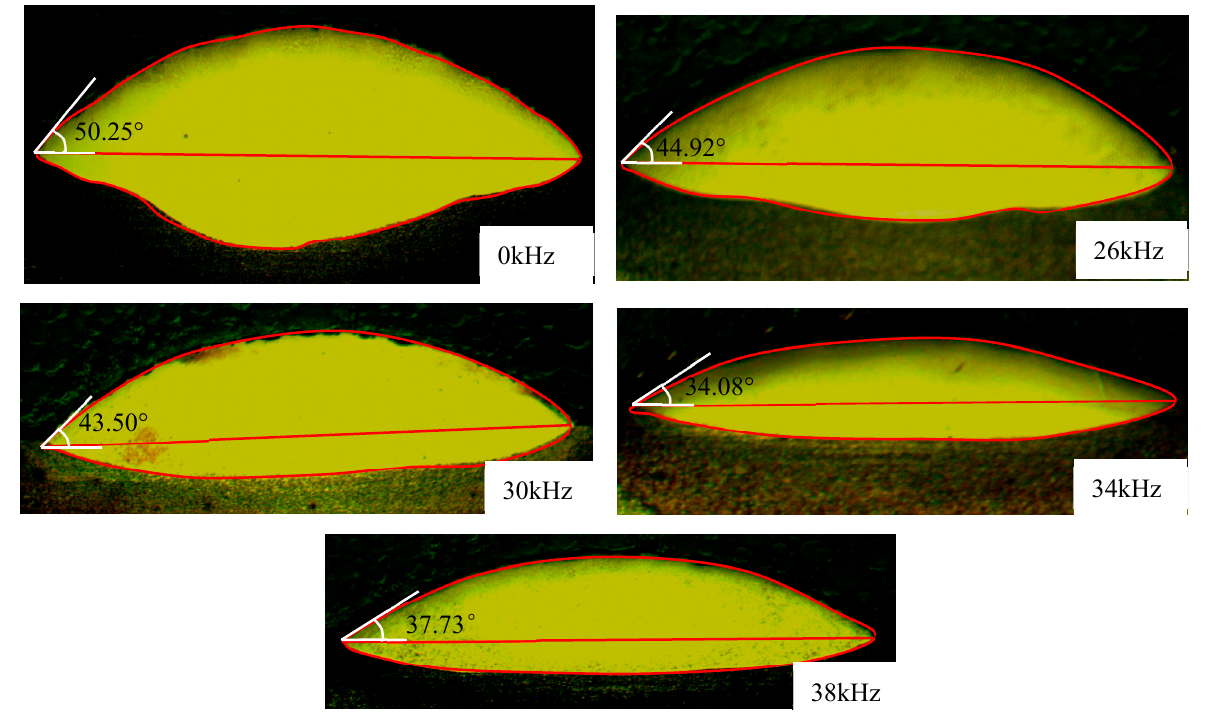
Figure 3. Cross-sectional morphology of the cladding layer at different ultrasonic frequencies.